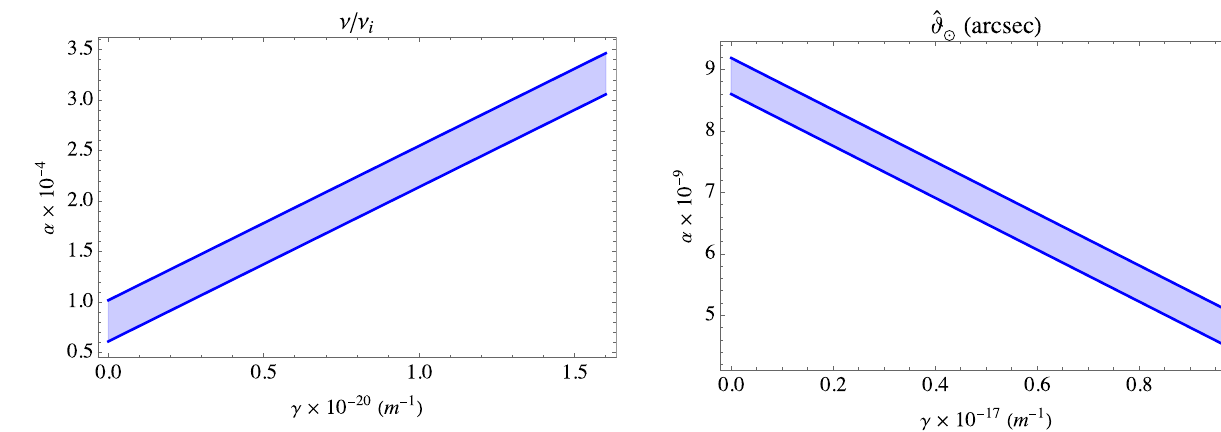
Fig. 3 The constraints on α and γ for the deflection angle of the